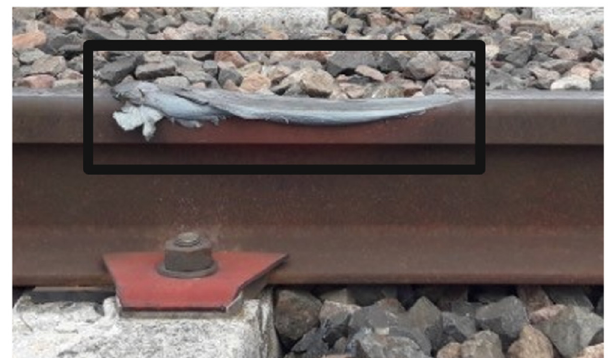
Fig. 1. Rail damage due to wheel-slip event in France; the squared area is the result of damage to the rails caused by train